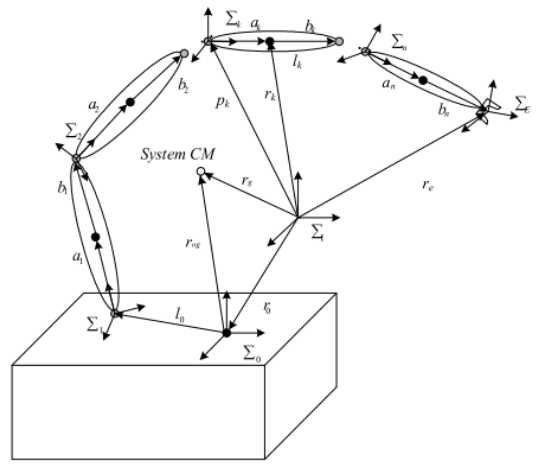
Figure 1. The simplified model of space manipulator.